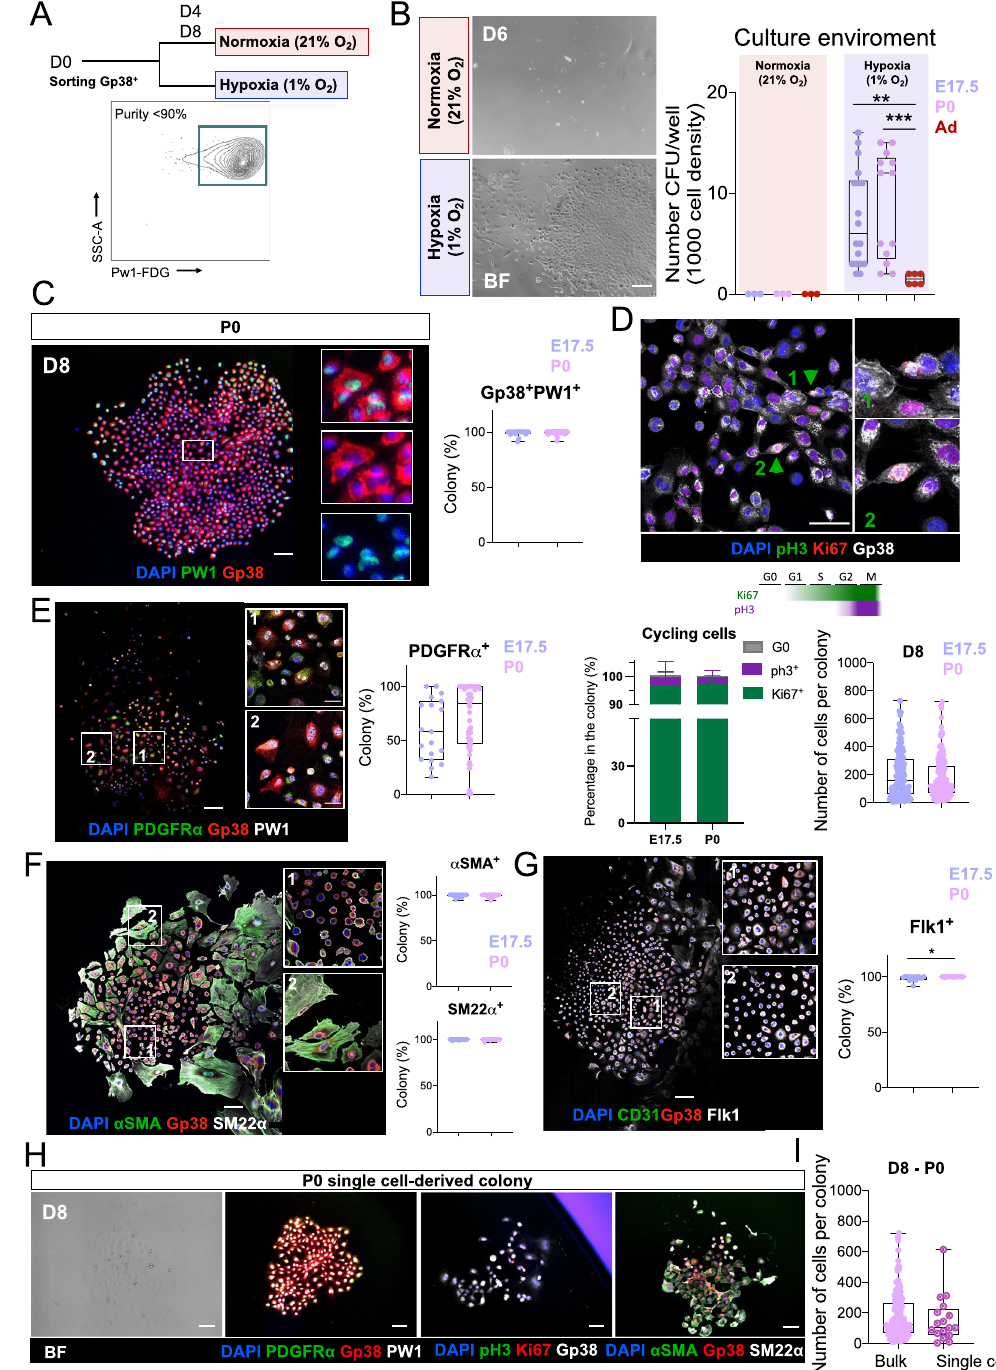
Figure 4. In vitro hypoxia maintains growth and cell fate potentials to Gp38 + PW1 + epicardial cells. ( A ) Schema of the in vitro experiment: cell sorting (Gp38 + Pw1 -FDG + cells) with a purity of more than 90% from E17.5, P0, adult (Ad) and in vivo hypoxia-primed adult (H-Ad) hearts. Freshly sorted cells were cultured from D0 to D8 either in normoxia (21% O 2 ) or hypoxia (1% O 2 ). ( B ) Frequency of colonies (1000 cells/well) cultured either under normoxia or hypoxia in vitro condition and the respective brightfield pictures of the cobblestone-like Gp38 + colonies. ( C ) Immunolabeling shows the colonies keep the Gp38 and Pw1 expression similar to their initial ex vivo profile (clonogenicity). ( D ) Immunolabeling of the cell cycle makers Ki67 and pH3 highlights the proliferative profile (green arrowheads) of colony of Gp38 + PW1 + cells (self-renewal). ( E ) Epicardial-derived and stromal cell markers (Gp38 and PDGFRα) are observed in the main cell fraction of the colony. ( F ) Smooth muscle cell markers (αSMA and SM22α) are observed in the majority of the cells composing the Gp38 + colony. ( G ) Immature endothelial marker Flk1, but not CD31, is observed to be expressed in vitro in Gp38 + colonies. ( H ) Single cell-derived colonies confirm the multipotential ability of the Gp38 + PW1 + cells to express proteins of smooth muscle, stromal and immature endothelial cell. Scale bar: 100 μm. All nuclei were counterstained with DAPI. Statistical significance was determined by Mann–Whitney test. *** p < 0.001, ** p < 0.01, ** p < 0.05. BF Brightfield, E.17.5 embryonic day 17.5, P0 postnatal day 0, Ad